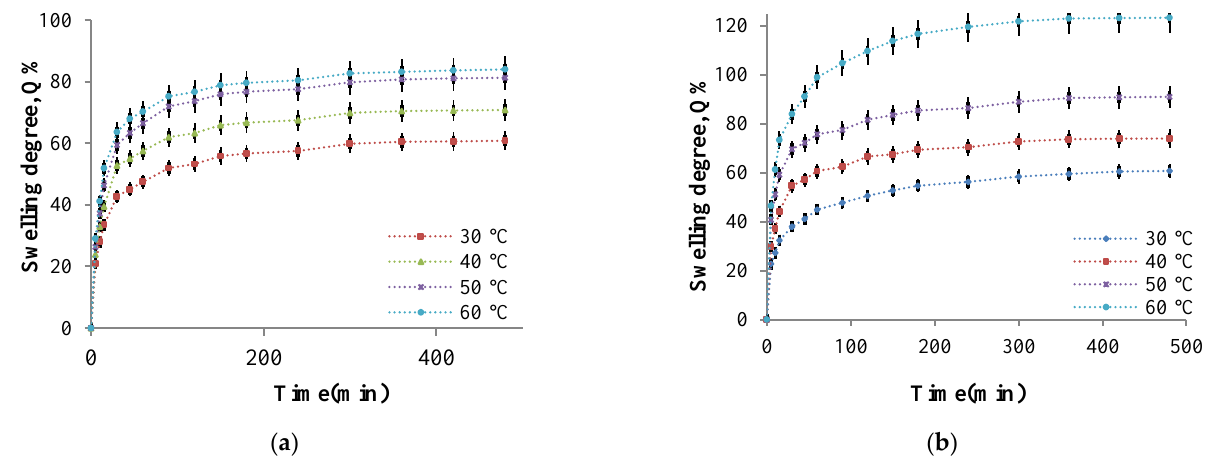
Figure 10. The variation in time of the swelling degree for the P2 sample prepared at different cross-linking temperatures in acetate buffer solution, pH = 5.5 ( a ) and in phosphate buffer solution at pH = 7.4 ( b ).